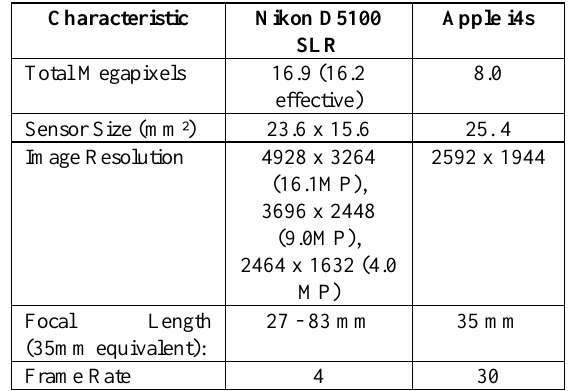
Figure 4. Work Flow diagram for conduct of experiment